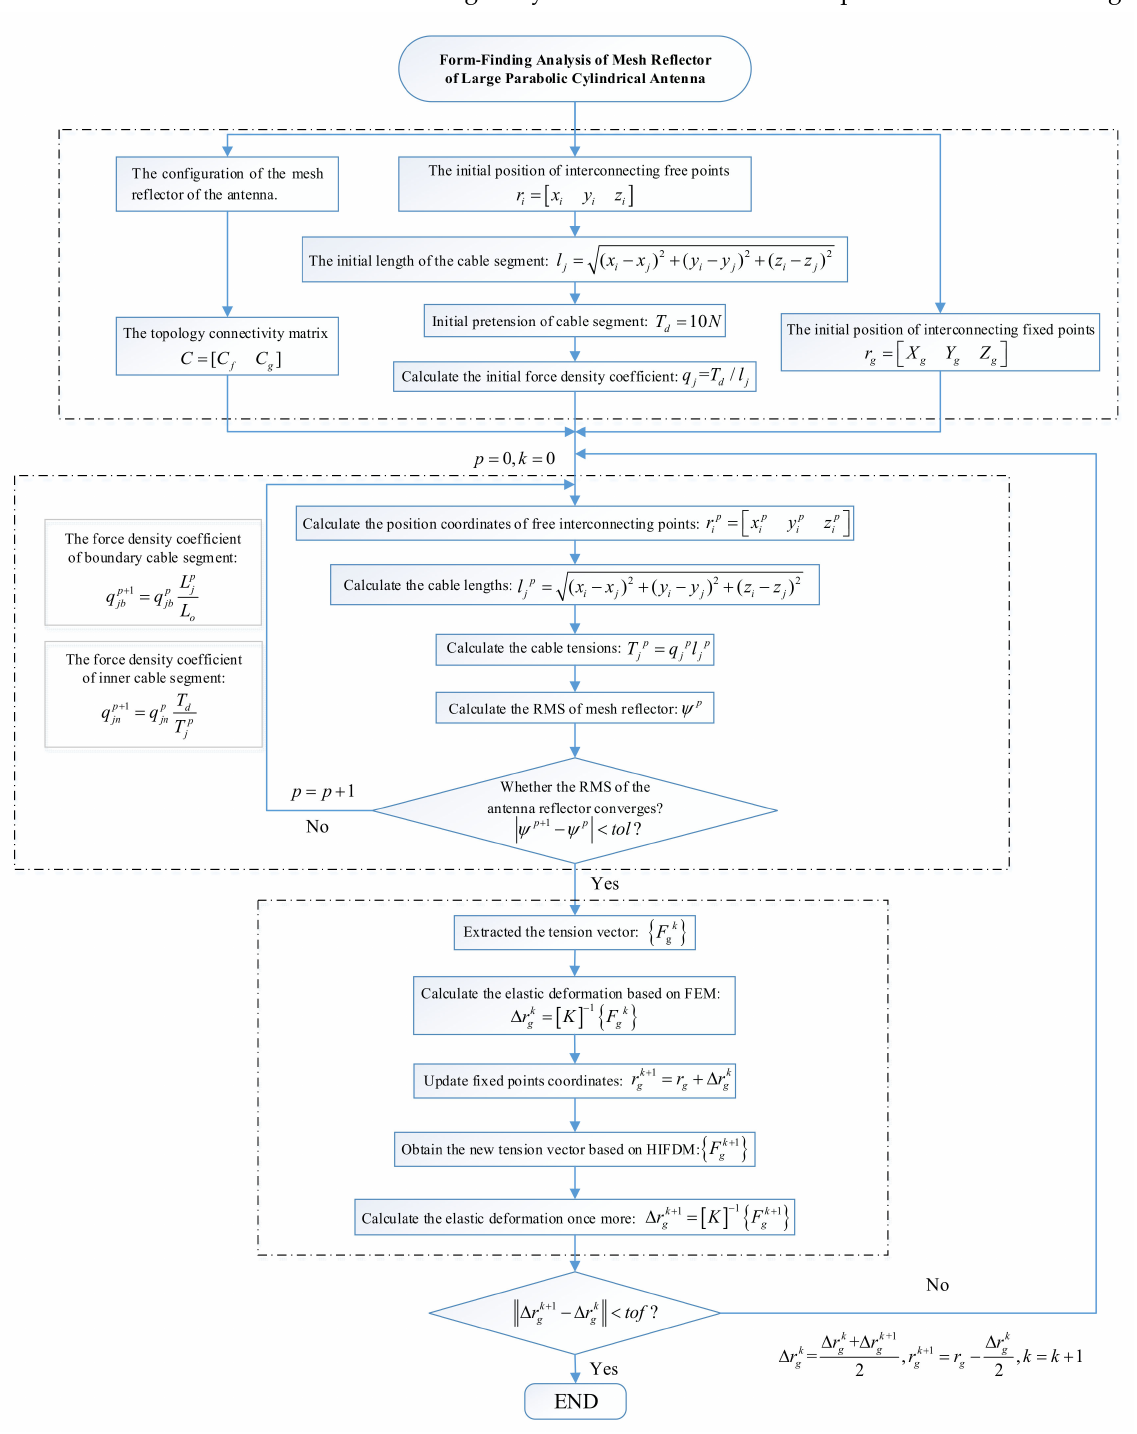
Figure 17. The form-finding analysis of the antenna reflector